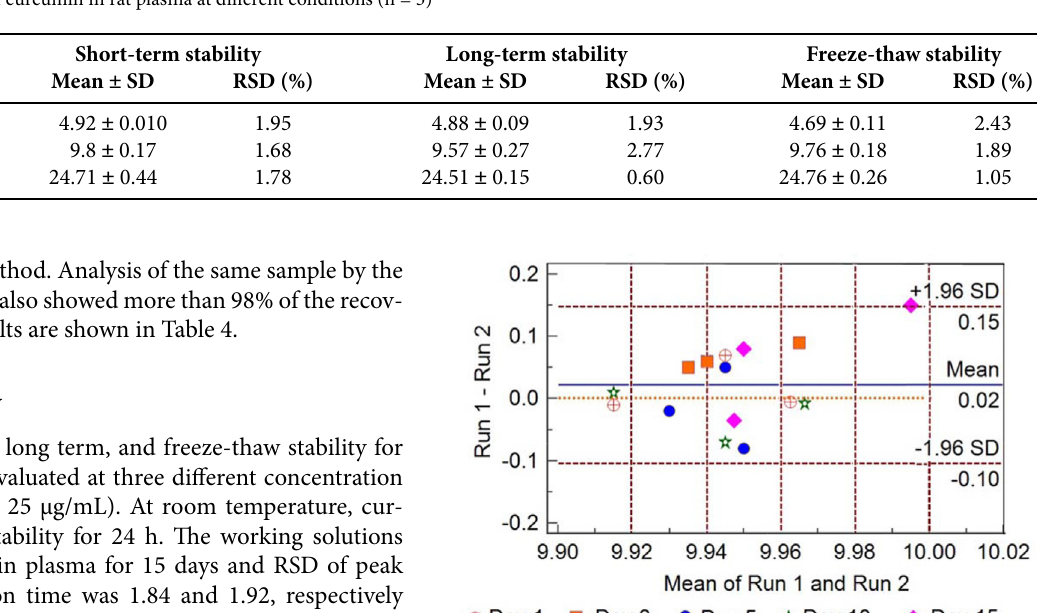
Fig. 4. The Bland-Altman plot for repetitive measurements for the same method